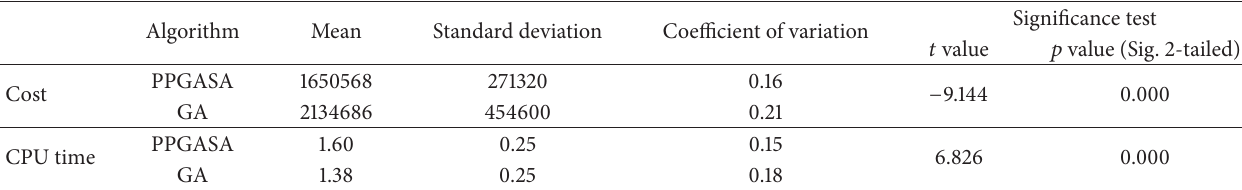
Table 7: Statistical results of optimal objective function value of two algorithms (cost: yuan, CPU time: